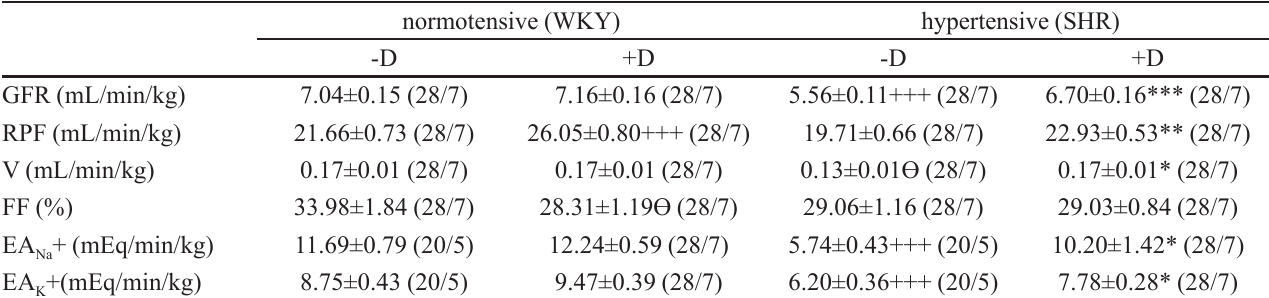
GFR = glomerular filtration rate, RPF = renal plasma flow, FF = filtration fraction, V = urine flow, EA sodium, EA + = excreted amount of potassium. Data is shown as mean ± SEM. Values between parentheses represent the number K of measurements/number of animals. * p < 0.05, ** p < 0.01, and *** p < 0.001 vs SHR-D and +++ p < 0.001 vs